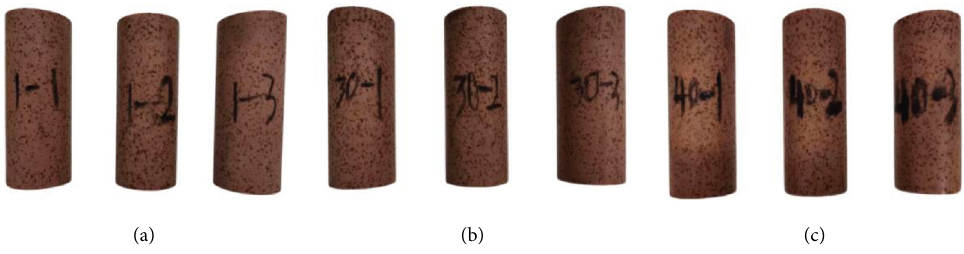
Figure 4: Freeze-thaw cycle results of yellow sandstone specimens. (a) 20 cycles. (b) 30 cycles. (c) 40 cycles.